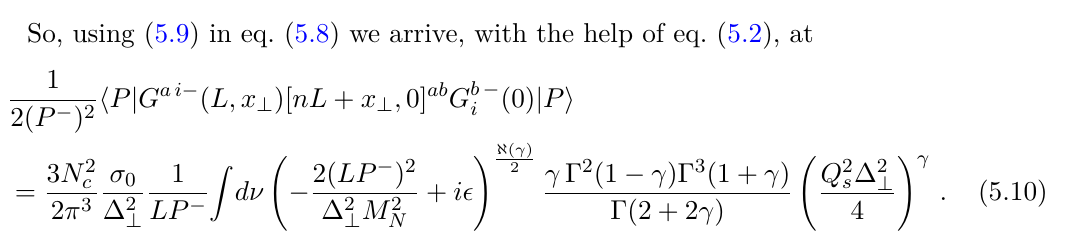
Figure 3 . Diagrammatic representation of the HE-OPE applied to the gluon non-local operator with “quasi-PDF